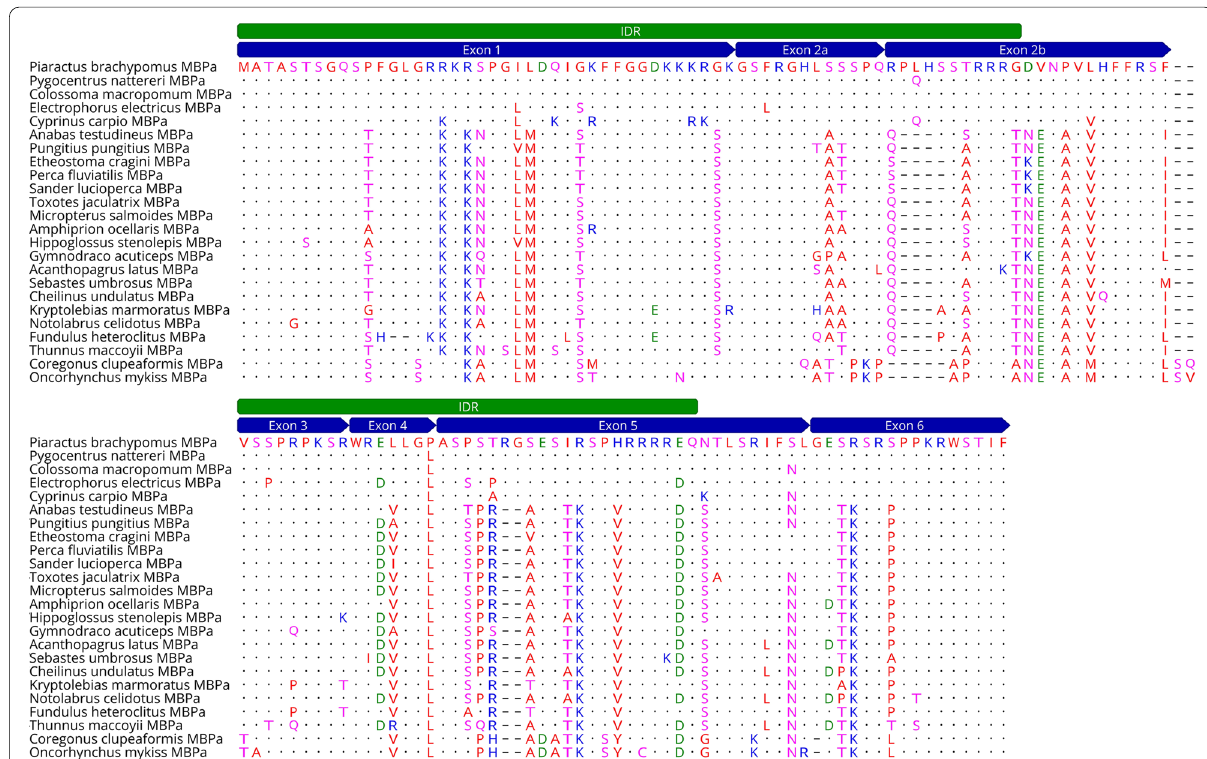
Fig. 1 Amino acid sequence alignment of MBPa protein from 24 fish species. Residues are colored according to physicochemical properties as follows: blue (basic: R, K, and H), red (hydrophobic: A, V, F, P, M, I, L, W, G, and Y), green (acidic: D and E), and pink (polar: S, T, N, Q, and C). Dots represent the conservancy among sequences. IDRs (green annotations); seven exons of MBPa encoded (blue